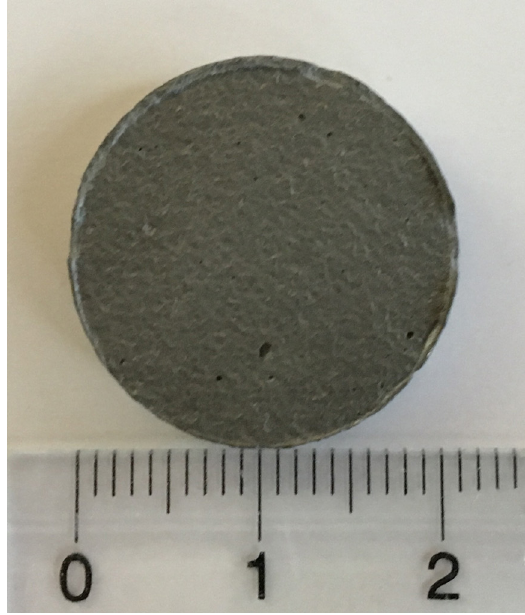
Figure 2. The photograph of one of the SPSed WC-Co cemented carbide specimen. Figure 4 shows the backscattered electron SEM micrographs of the obtained sintered compacts. The microstructure observations allowed the authors to highlight the ceramic and the binder distribution. The bright and grey contrast phases are the WC ceramic and Co binder respectively. The black areas correspond to pores. Rumman et al. 19 explained that in WC-Co cemented carbides pores tend to decrease in size with an increasing compaction pressure. They applied a compaction pressure ranging between 30 and 80 MPa and obtained a reduction in porosity from 3.12 to 2.12%. Moreover, the pores found on the low compaction pressure specimens were bigger and less homogenously distributed as opposed the microstructures are very fine, with a uniform grain-size distribution, only in the basic specimen and the specimen with the addition of 0.2 wt% Cr C . In other specimens 3 2